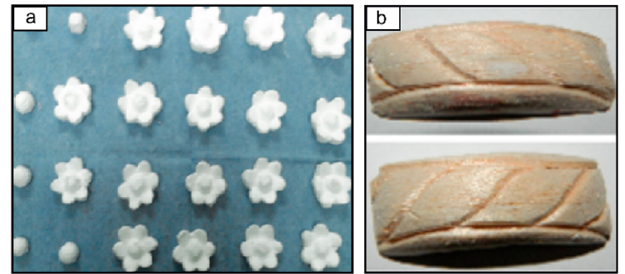
Figure 9. Lost ornamental elements made of balsa wood: ( a ) Buttons and ornamental flowers; ( b ) Capitals and plinths of the columns.